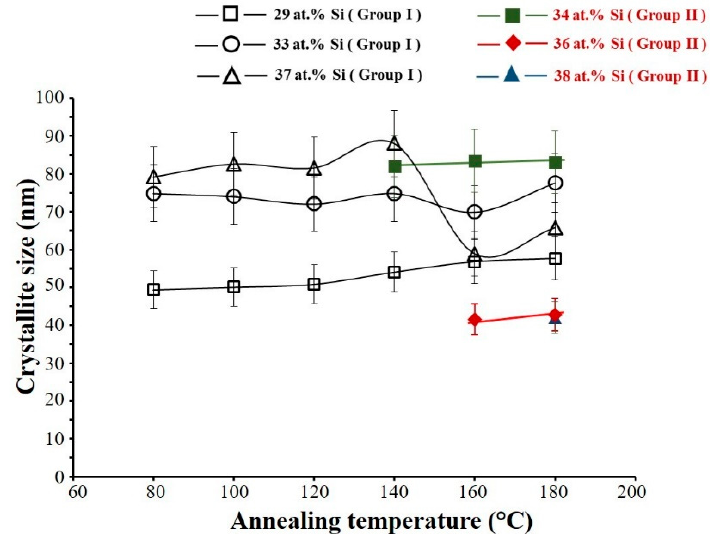
Figure 4. Crystallite size of the films measured by Scherrer law as a function of annealing temperature. (Group I: R P < 7 × 10 − 4 Pa and Group II: R P ≥ 7 × 10 − 4 Pa).